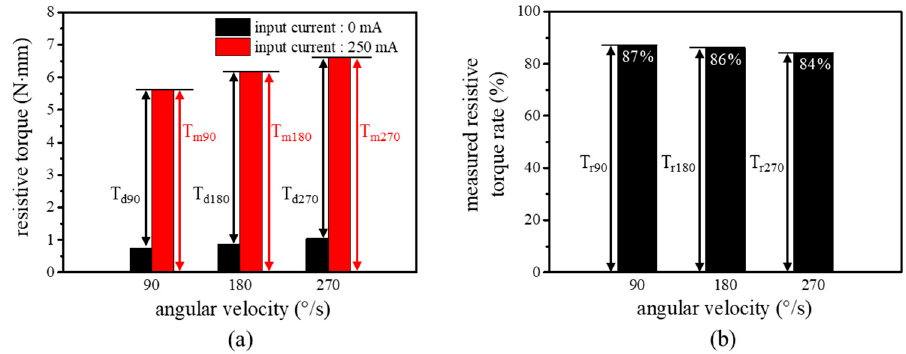
Figure 12. ( a ) Resistive torque and ( b ) measured resistive torque rate at three angular velocities (90 °/s, 180 °/s, and 270